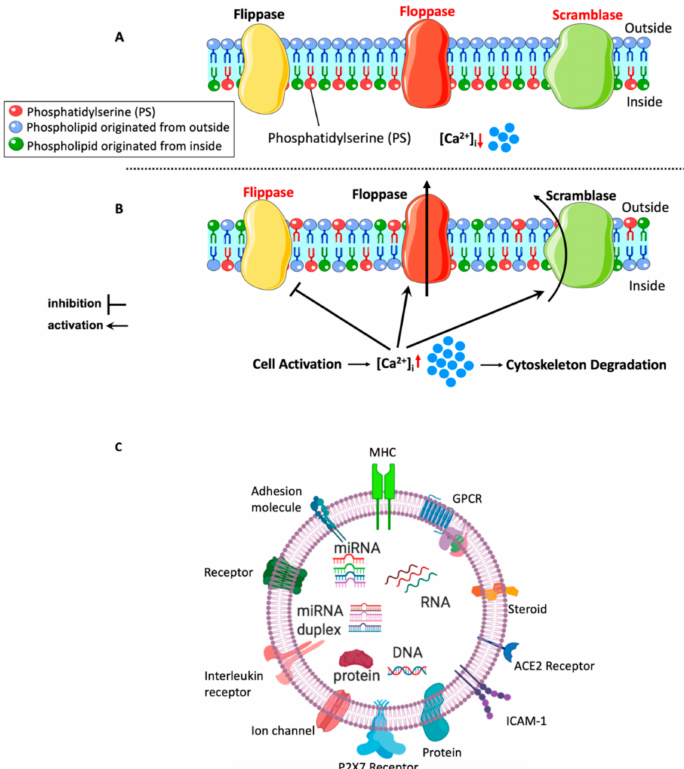
Figure 3. Mechanism of large size extracellular vesicles (lEV) (microparticles: MP) formation ( A , B ) and cargo content of lEVs (MPs) in biological materials and cell surface proteins and antigens ( C ). ( A ) At resting state, Ca + 2 levels are low and membrane lipid distribution is maintained by flippase enzyme with phosphatidylserine kept in the inner leaflet of the plasma membrane; ( B ) upon cell activation, Ca + 2 levels are elevated leading to disruption of the cytoskeleton proteins. Moreover, Ca + 2 inhibits the action of flippase enzyme and activates floppase and scramblase enzymes. Floppase translocates inner leaflet lipids to the outer leaflet and scramblase moves lipids down their concentration gradient, leading to externalization of phosphatidylserine and membrane remodeling. These mechanisms are thought to be involved in lEV (MP) formation. Abbreviations: lEVs, large extracellular vesicles; MPs, microparticles; MHC, major histocompatibility complex; GPCR, G-protein coupled receptor; ICAM-1, intercellular adhesion